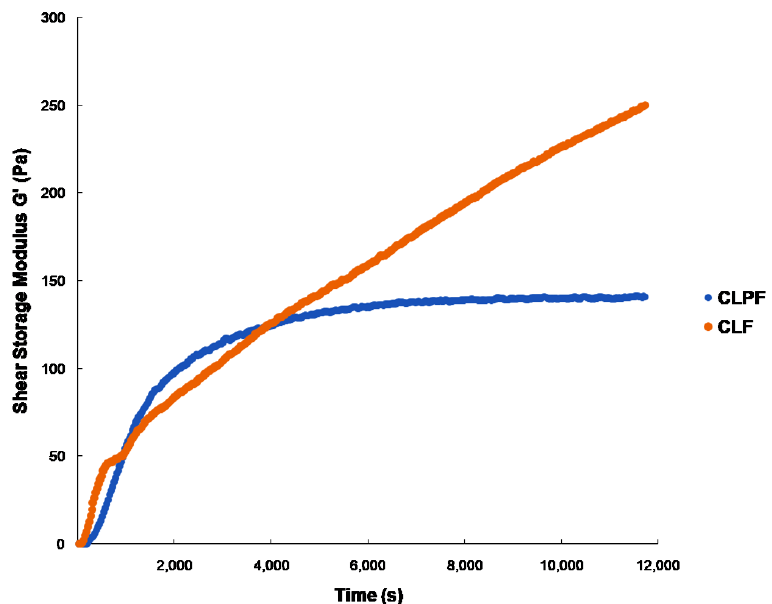
Figure 3. Kinetic gelation plots of unloaded and PZQ-loaded SLNs showing the shear storage modulus (G′) (Pa) observed over the periods of 3 h at 37 °C. CLF and CLPF represent the formulations of Compritol-lecithin-solid lipid nanoparticles and PZQ-loaded Compritol-lecithin-solid lipid nanoparticles with PF127 as a surfactant.